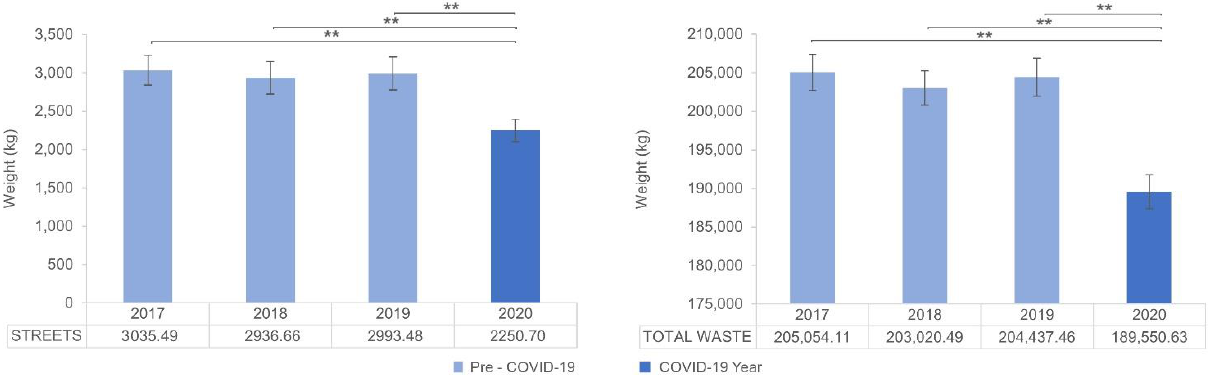
Figure 4. Mean and 95% CI for each year in waste fractions of Group 3: streets and total waste collection. (**) for p < 0.01. Table 6. Significant differences in streets and total waste collection from Bonferroni’s comparison test. Streets Total